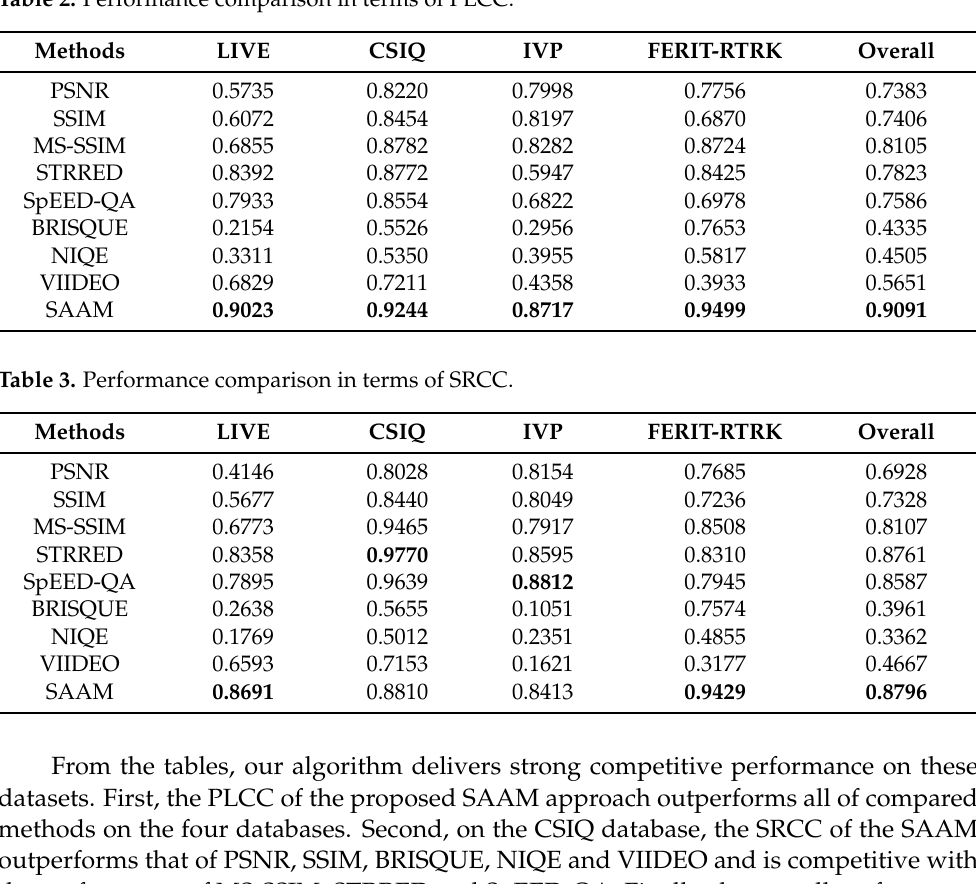
Table 2. Performance comparison in terms of PLCC.